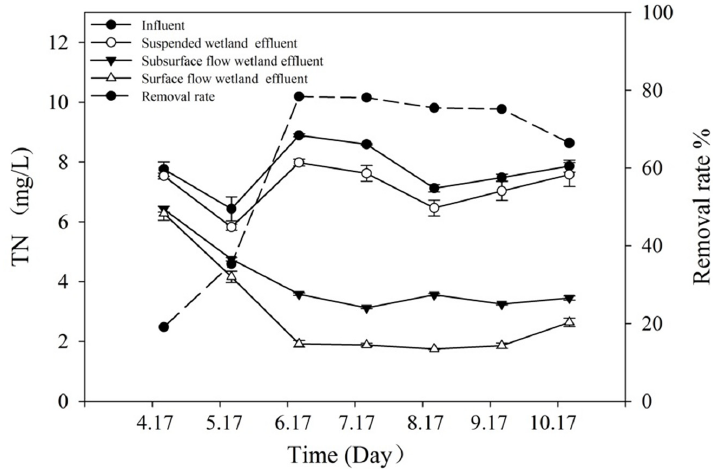
Figure 7. Concentration of TN in the inflow and outflow and the removal rate.